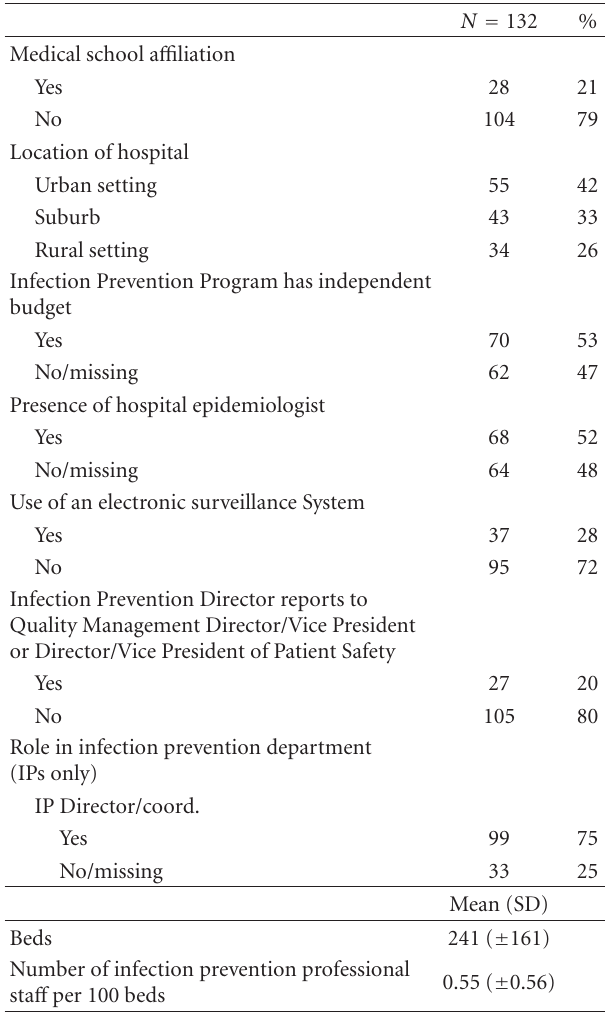
Table 1: Hospital and infection prevention and control department